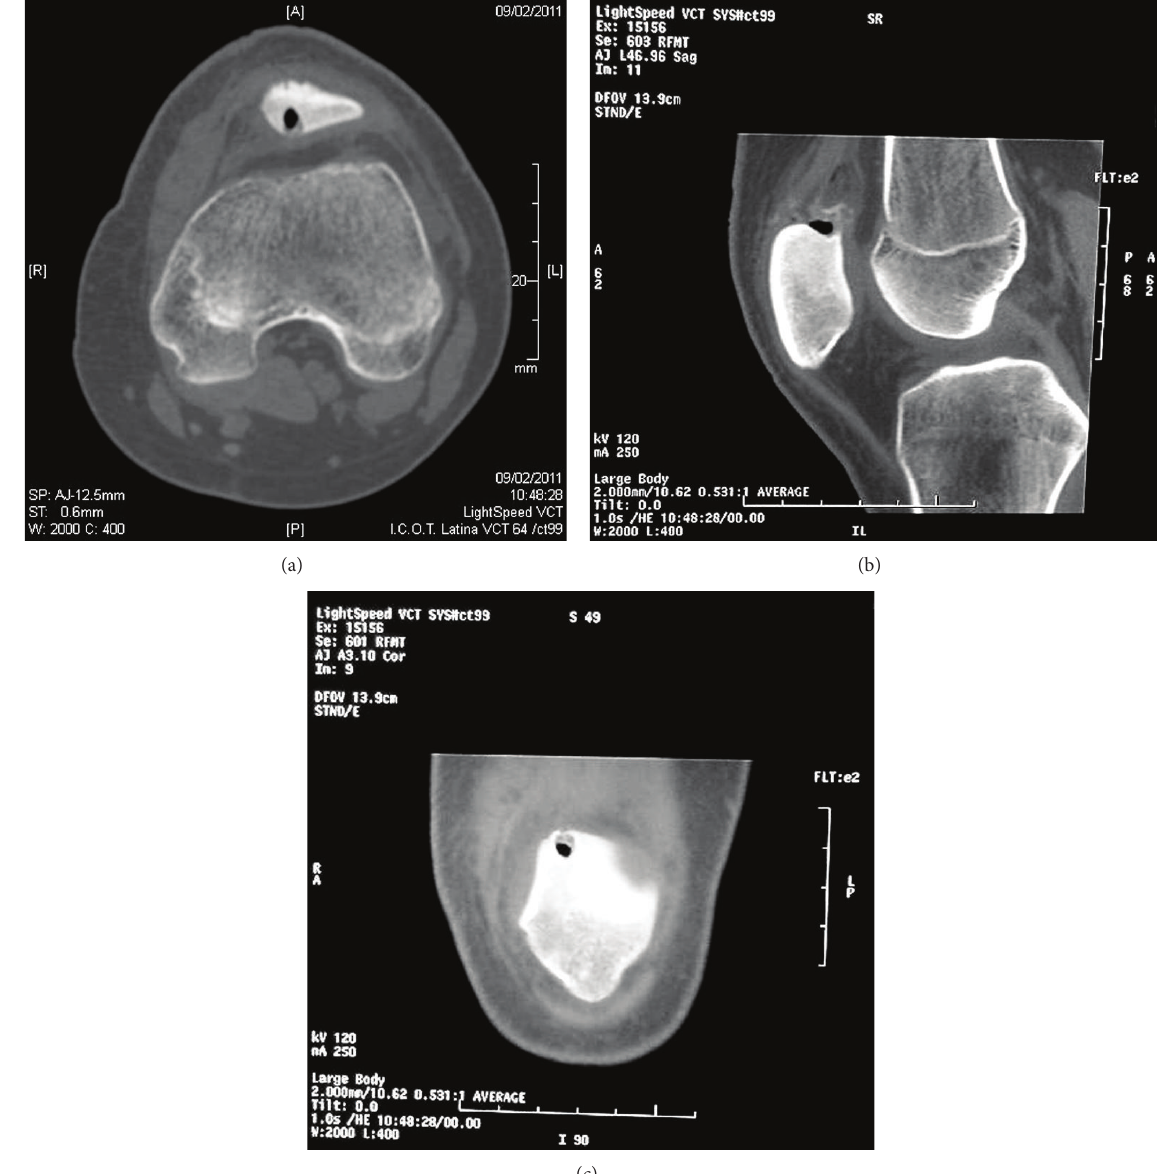
Figure 4: Postoperative CT scans confirm the disappearance of the nidus ((a) axial; (b) sagittal; (c) coronal